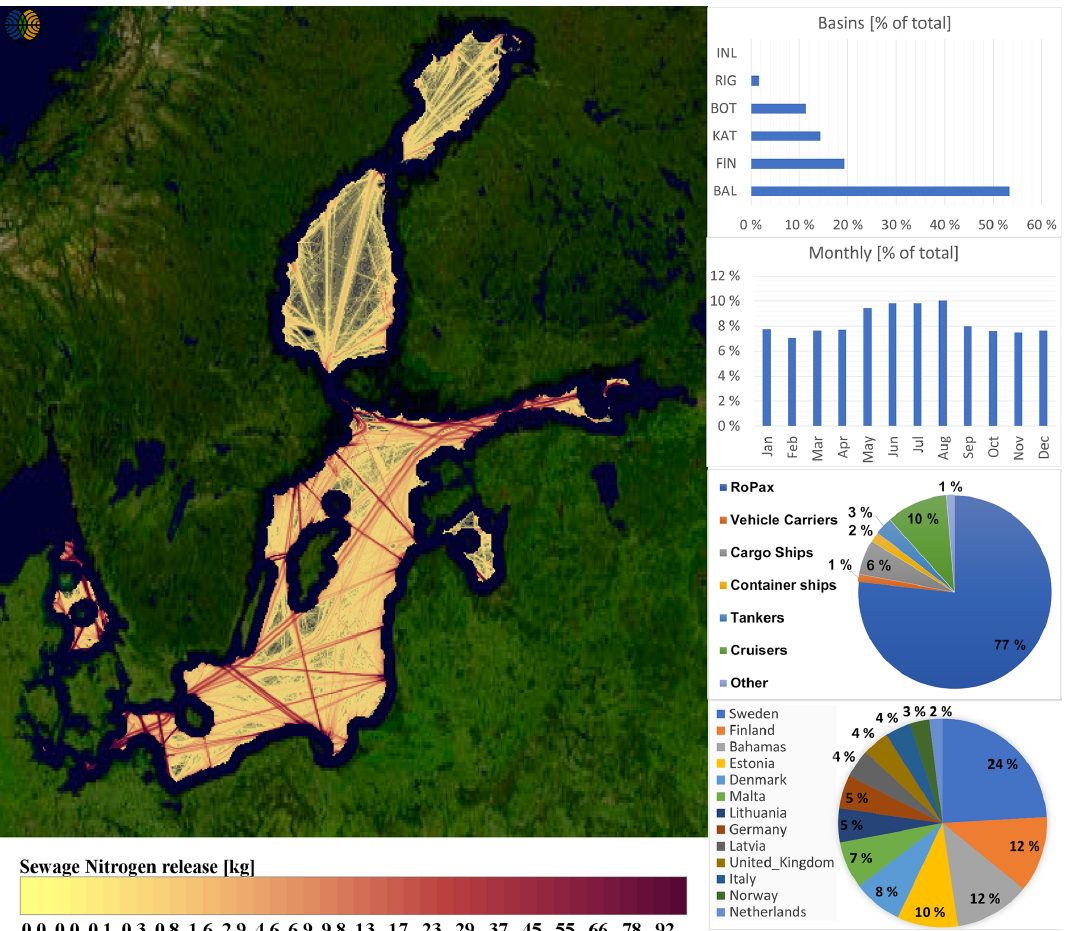
Figure 11. Sewage nitrogen discharges from ships during 2012 in units of kilograms per map grid cell area of 5km 2 . According to IMO rules, no discharge is allowed closer than 12nm distance from the coastline. the upper bar chart describes the contributions by sub-basin and the lower bar chart the monthly variation. The upper pie chart depicts the ship type and the lower pie chart the flag state contributions to sewage nitrogen releases. Map: background Landsat-8 image courtesy of the US Geological